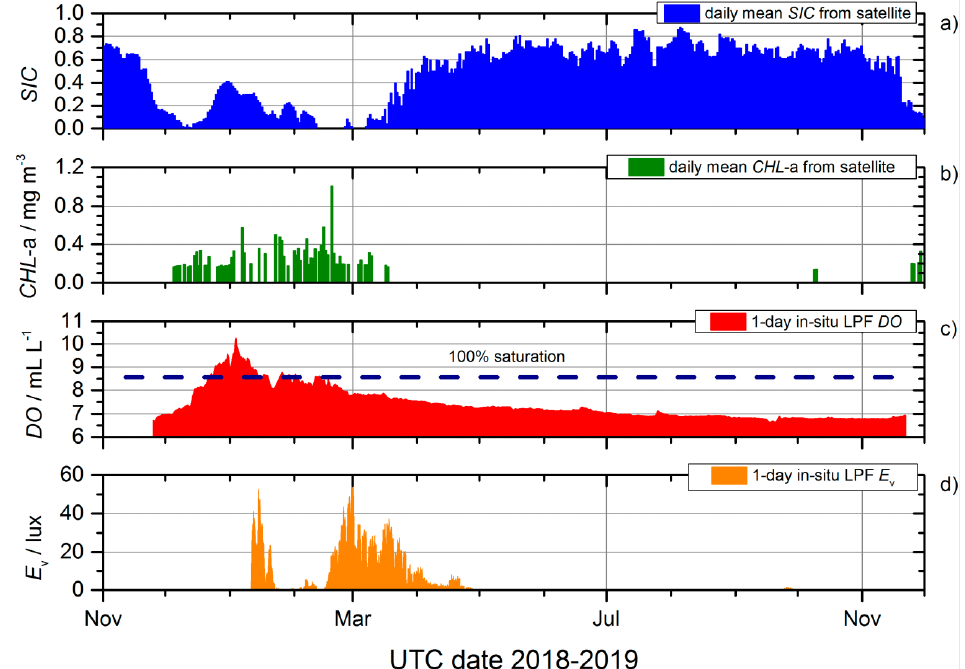
Figure 7. Daily mean satellite data of SIC and Chl -a compared with experimental DO and E v (moving window of 24 h). Annual trends of ( a ) SIC , ( b ) CHL-a , ( c ) DO and ( d ) E v for the period November 2018–November 2019 in Terra Nova Bay.